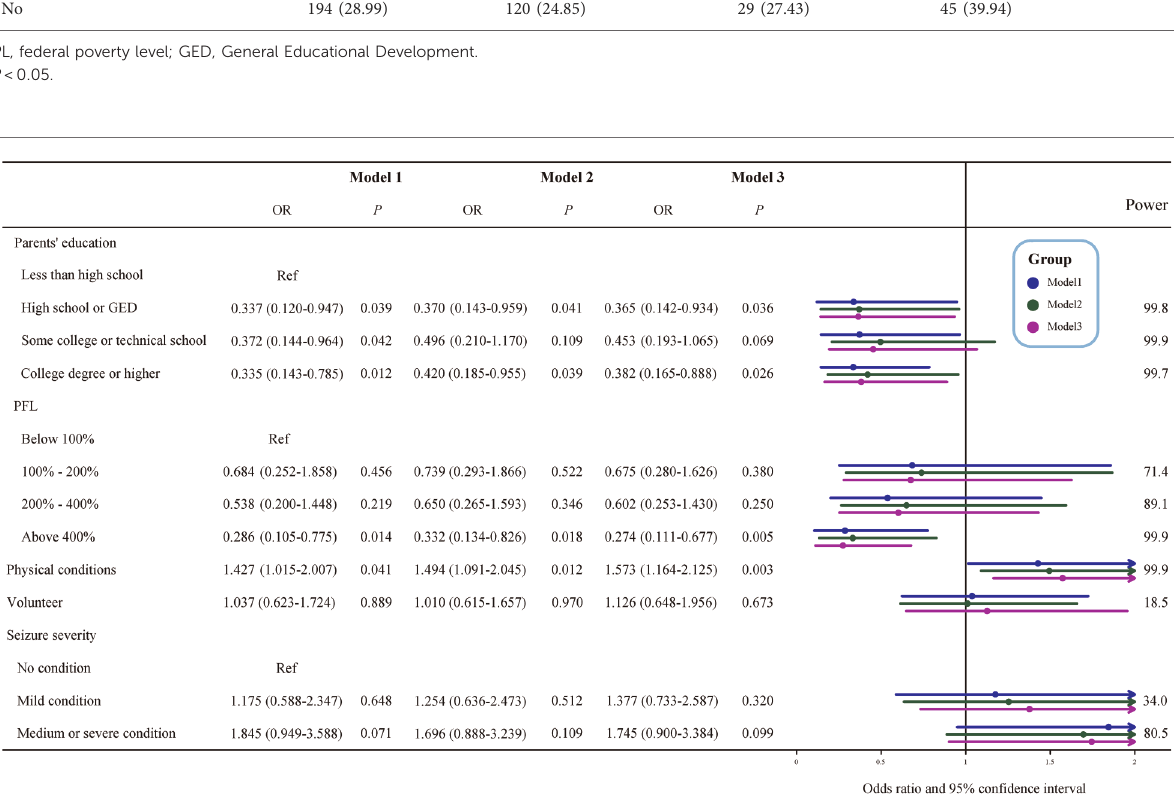
FIGURE 2 Multivariate ordinal logistic regression of characteristics for obesity. Model 1 was the crude model, Model 2 adjusted for sex, age, and race, and Model 3 adjusted for sex, age, race, use of cigarets, cigars, or pipe tobacco inside, afterschool activity, and physical activity. OR, odds ratio; Ref, reference; PFL, federal poverty